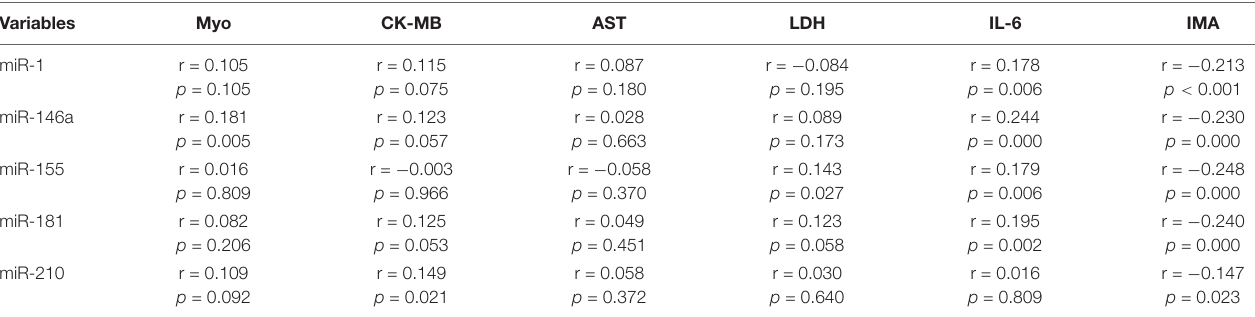
TABLE 2 | The Spearman’s rank correlation coefficients between altered microRNAs and cardiovascular diseases-associated clinical biochemical parameters in 120 young soldiers. Variables